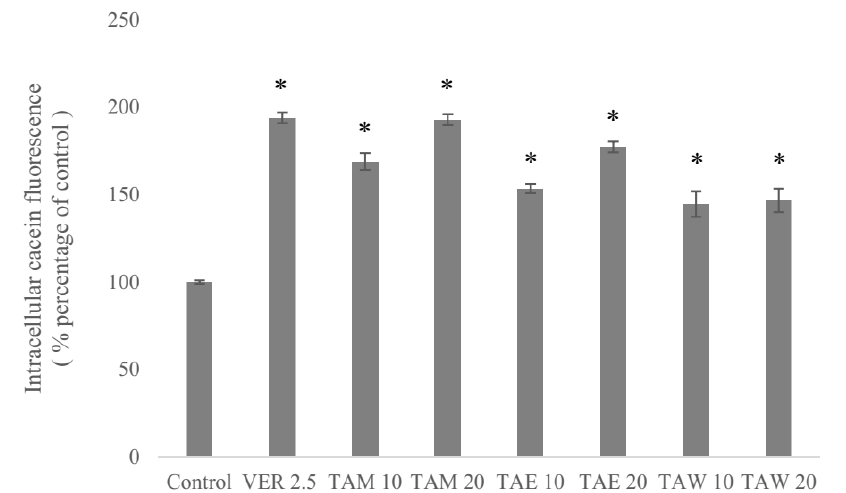
Figure 5. The inhibitory effects of the methanol extract at 10 and 20 μ M concentrations (TAM 10, TAM 20), the EtOAc layer (TAE 10, TAE 20), the water layer (TAW 10, TAW 20) and verapamil at 2.5 μ M concentration (VER 2.5) on P-glycoprotein (P-gp) in ABCB1 /Flp-In TM -293 cells. * denotes p < 0.05 compared with the intracellular calcein fluorescence in the control group. The numbers, 2.5, 10, 20, indicate the μ M concentrations.